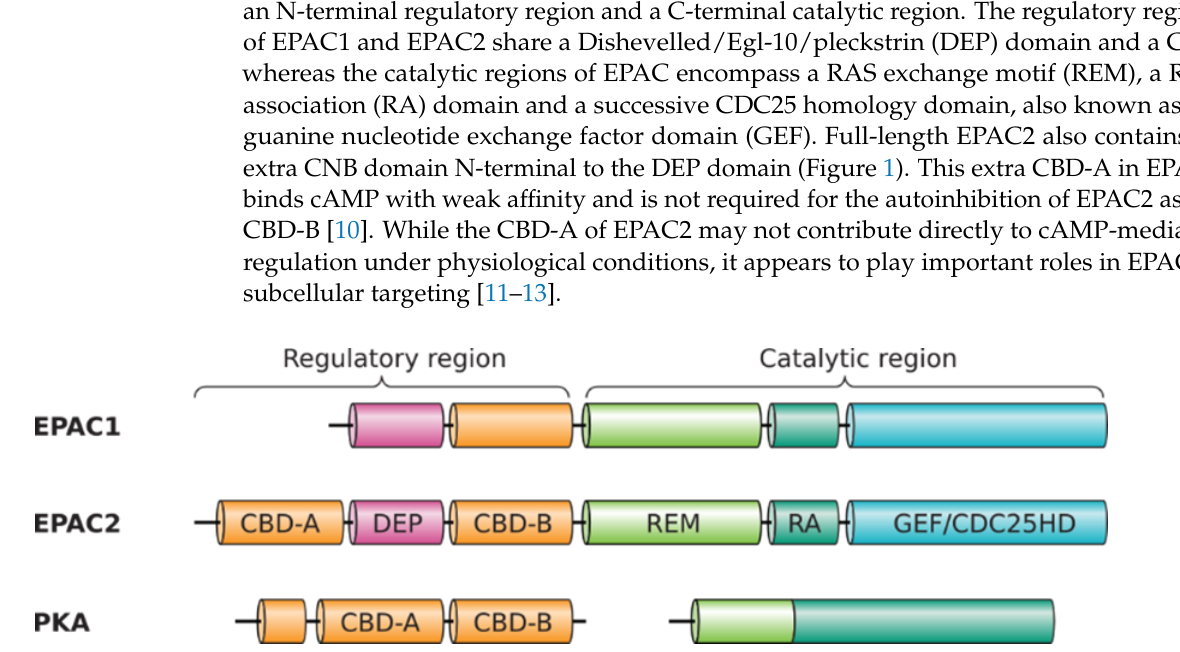
Figure 1. Domain structure of the EPACs and PKA. Individual domains indicated: CBD, cAMP-binding domain; DEP, disheveled, EGL-10 and pleckstrin homology domain; REM, RAS exchange motif; RA, RAS association domain; GEF/CDC25HD, guanine nucleotide exchange factor domain/CDC25 homology domain.